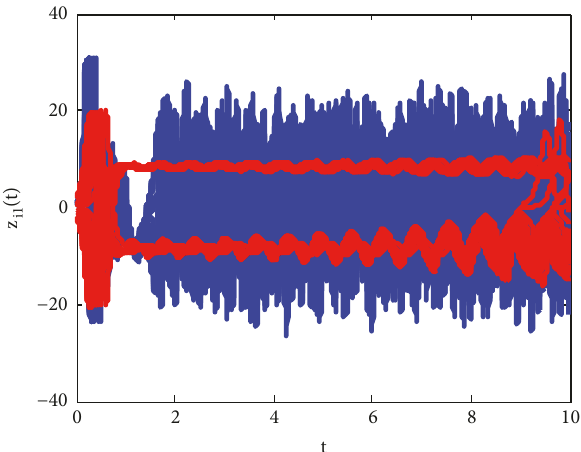
Figure 2: (Color online) Evolution patterns of community network 𝑧 (𝑡) with 𝑡 . 𝑖1